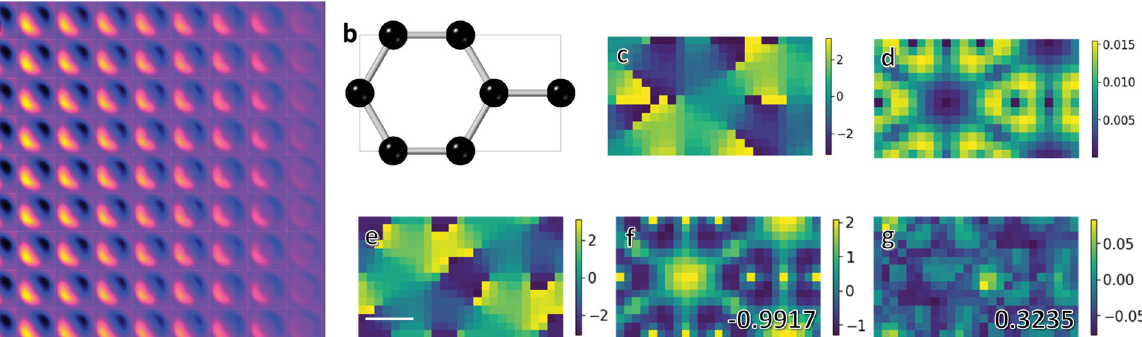
Fig. 3 Application to simulated graphene CBED patterns. a Latent space for 3D rrVAE of simulated graphene CBED patterns for microscope operating a 60 kV with a 31 mrad probe forming aperture. b Model of the unit cell used for multi-slice simulation. c , d Angle and magnitude of the COM de fl ection calculated from the simulated CBED patterns, respectively. e Rotation map obtained from rrVAE analysis. Scale bar on ( e ) is 1 Å. f , g Two latent variable distributions (with Pearson r factor inset). Published in partnership with the Shanghai Institute of Ceramics of the Chinese Academy of